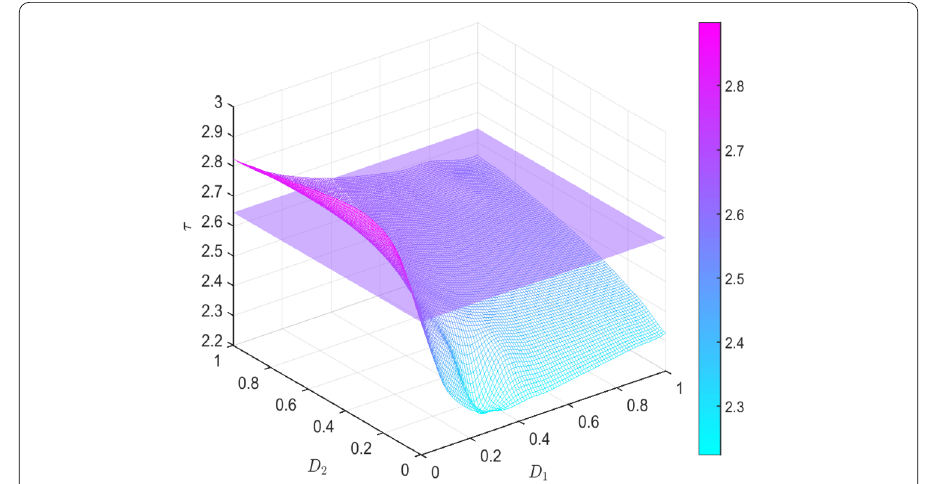
Figure 4 The joint effects of dispersal rates D 1 , D 2 on τ 0